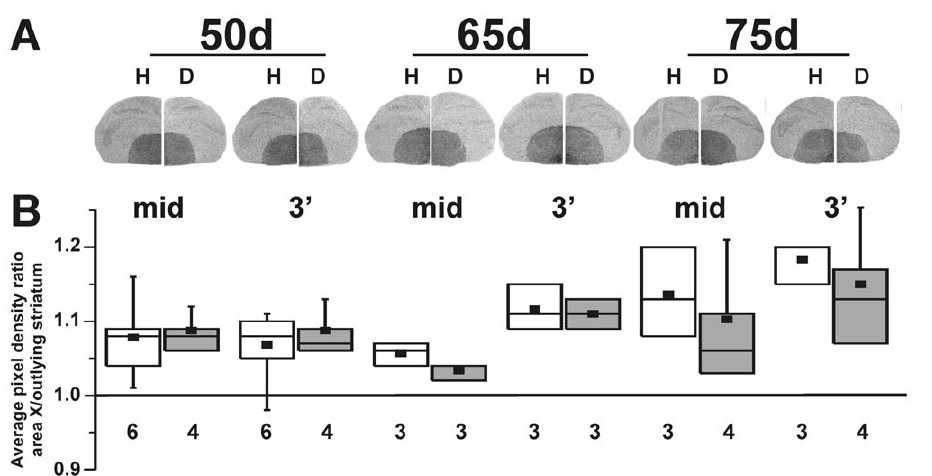
Figure 2. Basal FoxP2 levels are similar between hearing and deafened juveniles. A ) Exemplar hemi-coronal sections show FoxP2 signals detected with either the mid or 3 9 -probe at 50, 65 and 75d in hearing (H; left hemi-sections) or deaf (D; right hemi-sections) birds. B ) Quantification of pixel density within area X, normalized to values of the outlying striatum, reveals stable expression regardless of age or hearing condition. With each probe, at each age, and in each condition (white boxes=hearing, shaded boxes=deaf), values exceed unity (1.0), indicating slightly higher expression within area X. No differences were detected with either probe (Mean 6 SEM: H-NS vs. D-NS – 3 9 -probe: 50d, 1.07 6 0.02 vs. 1.09 6 0.02; 65d, 1.12 6 0.03 vs. 1.11 6 0.02; 75d, 1.18 6 0.02 vs. 1.15 6 0.07. Kruskal-Wallis H =10.7, df=5, p =0.06; mid-probe: 50d, 1.08 6 0.02 vs 1.09 6 0.01; 65d, 1.06 6 0.01 vs. 1.03 6 0.01; 75d, 1.14 6 0.03 vs. 1.10 6 0.04. Kruskal-Wallis H =8.7 p =0.12). ‘Box and whiskers’ plots show the median (line), average (filled small rectangle), 25 th and 75 th percentiles (box) and 5 th and 95 th percent confidence intervals (whiskers) for each group. The number of birds per group is indicated beneath. For each bird, multiple sections were analyzed, then averaged, to produce a single metric per bird.